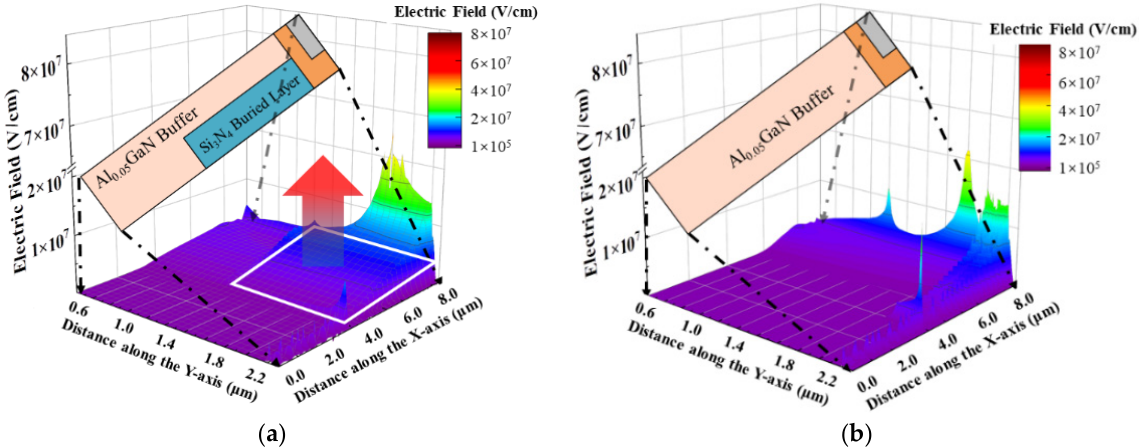
Figure 4. The 2-D electric field distribution in the whole buffer region of ( a ) BP-HEMT and ( b ) DC-HEMT.